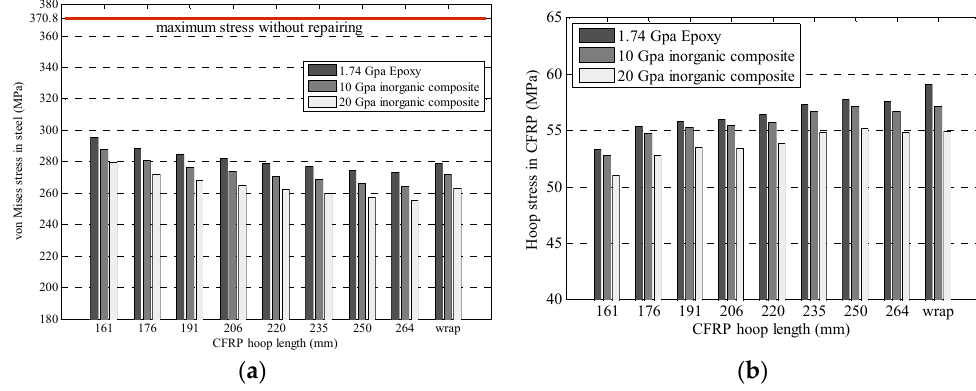
Figure 6. Effect of infill modulus on ( a ) von Mises stress in pipe and ( b ) hoop stress in CFRP.